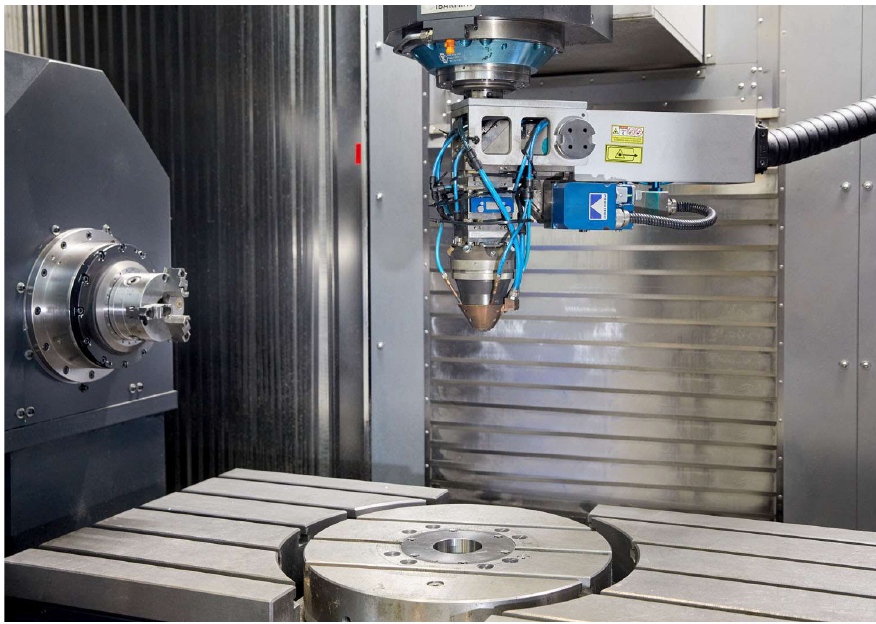
Figure 1. IBARMIA ZVH45/1600 Add+Process hybrid